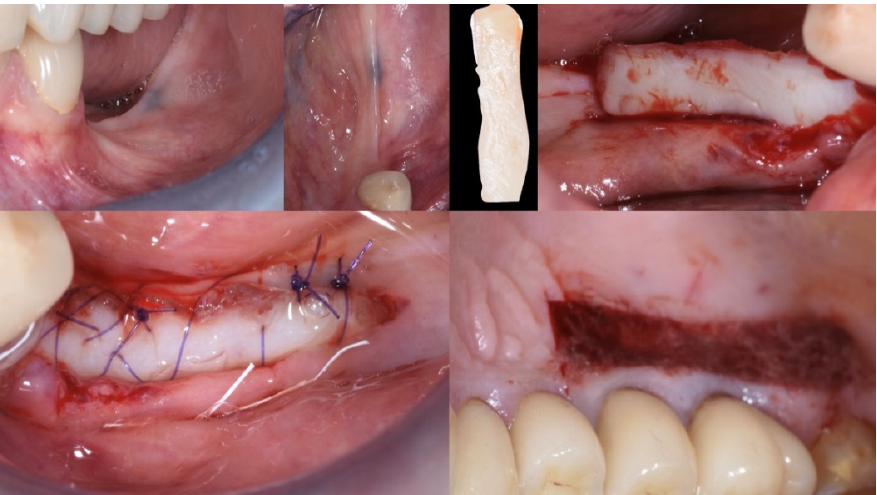
Figure 4. Mucogingival surgery. A free gingival graft was used to enhance both the quality and quantity of the soft tissue of the edentulous ridge.